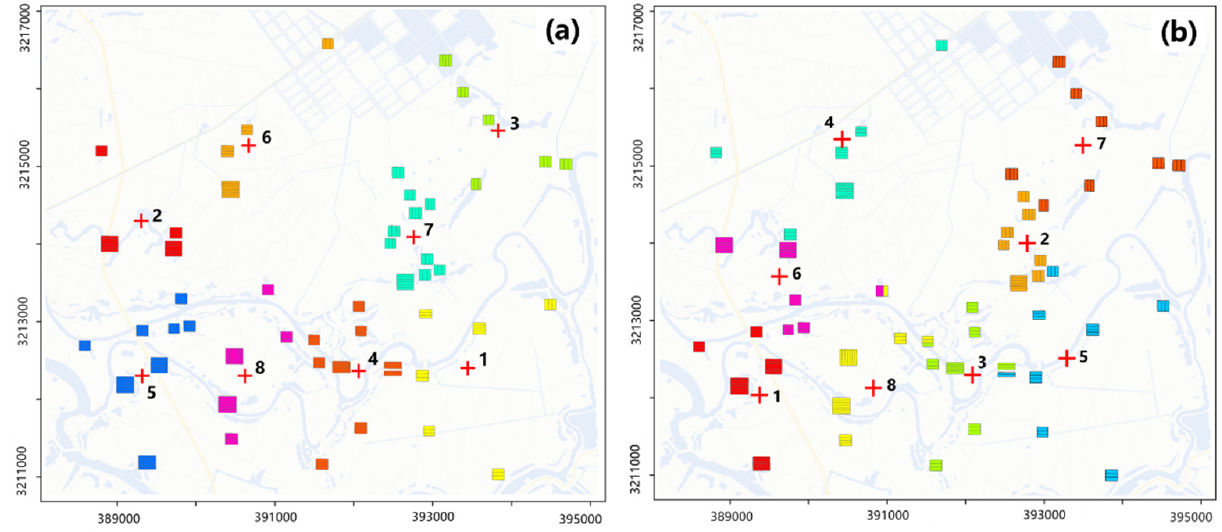
Figure 6. Results of the ( a ) generic K-means and ( b ) task-balanced restricted K-means.